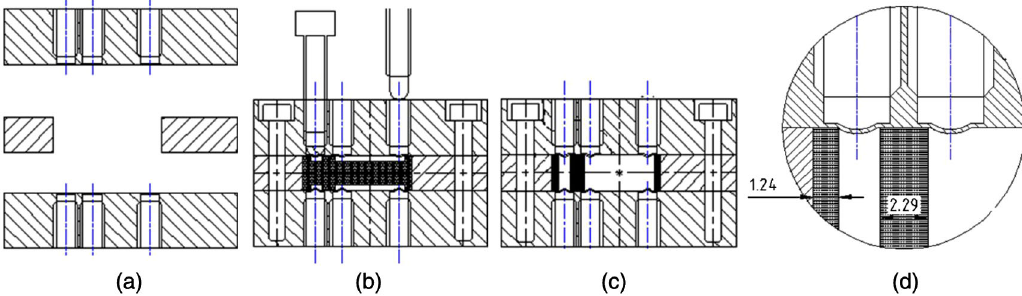
FIG. 8. Sequence of steps to ensure accurate positioning of slabs (see description in the